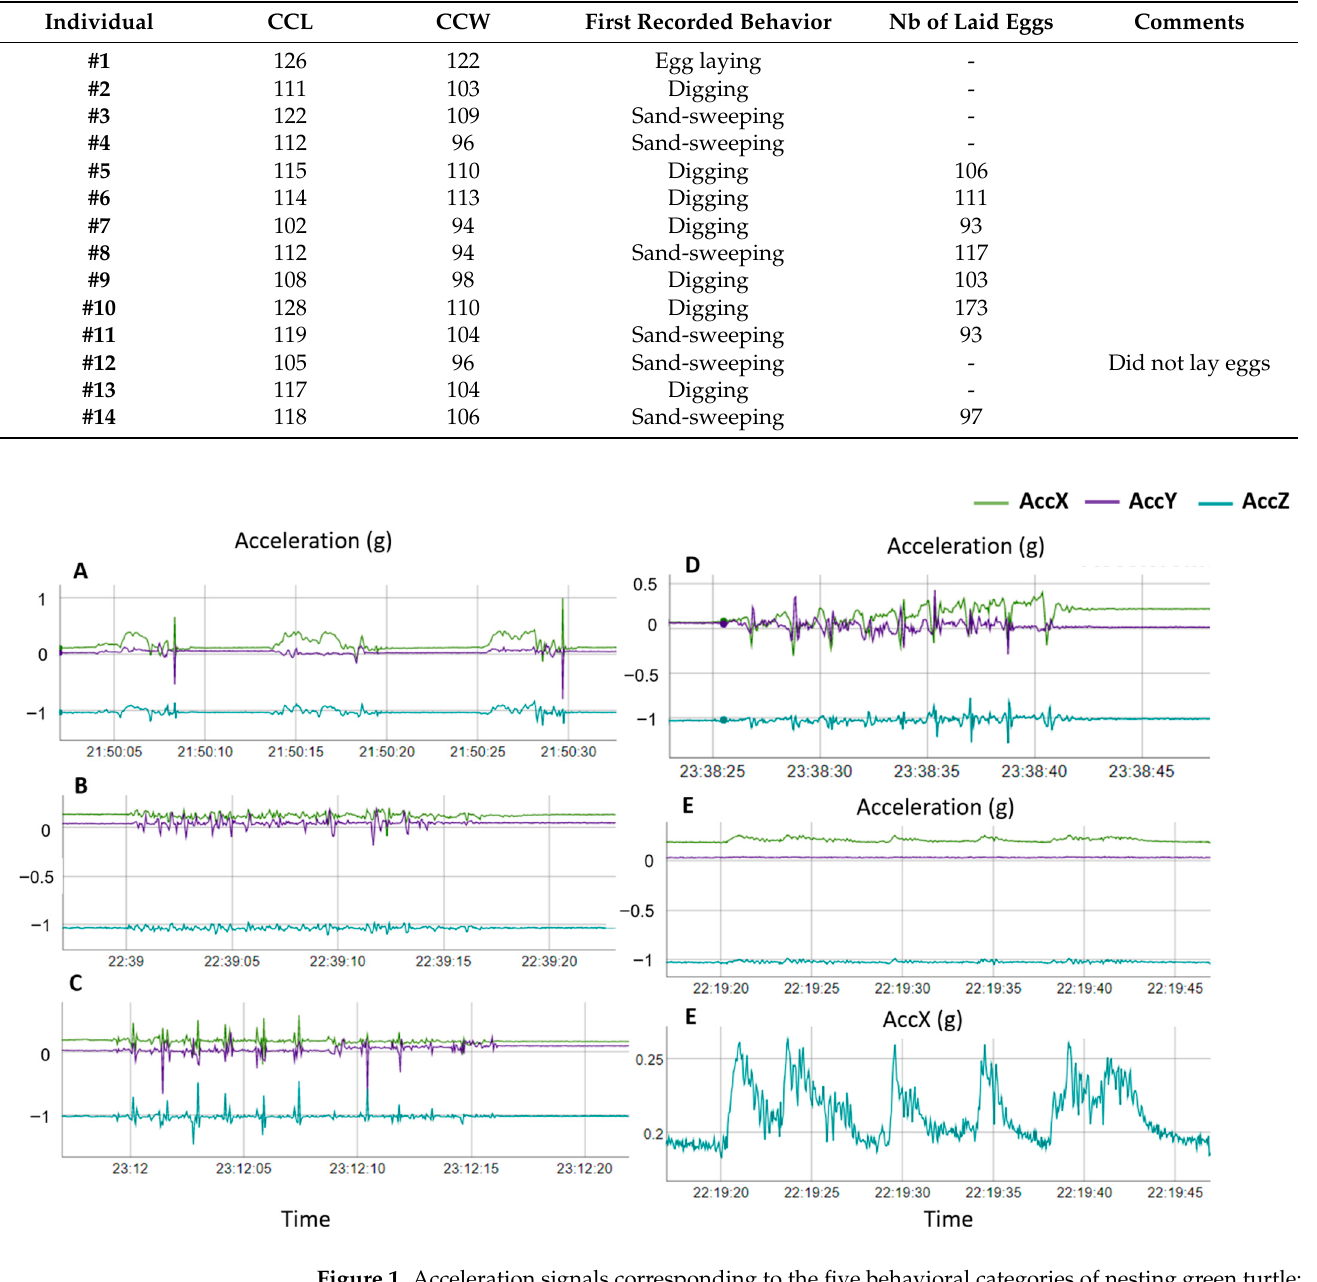
Figure 1. Acceleration signals corresponding to the five behavioral categories of nesting green turtle: Digging ( A ); Covering ( B ); Sand-sweeping ( C ); Walking ( D ); and Egg laying ( E ). We also represent the X-axis of the acceleration of Egg Laying. AccX corresponds to acceleration of the back -to-front body axis, AccY to the left-to-right axis and AccZ to the bottom-to-top axis.